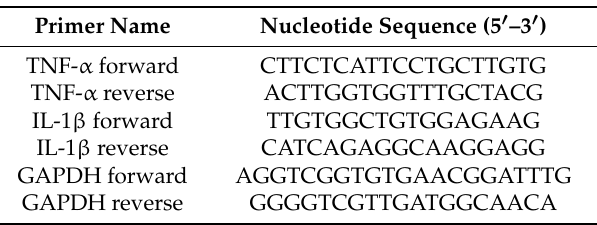
Table 1. Primers used in this